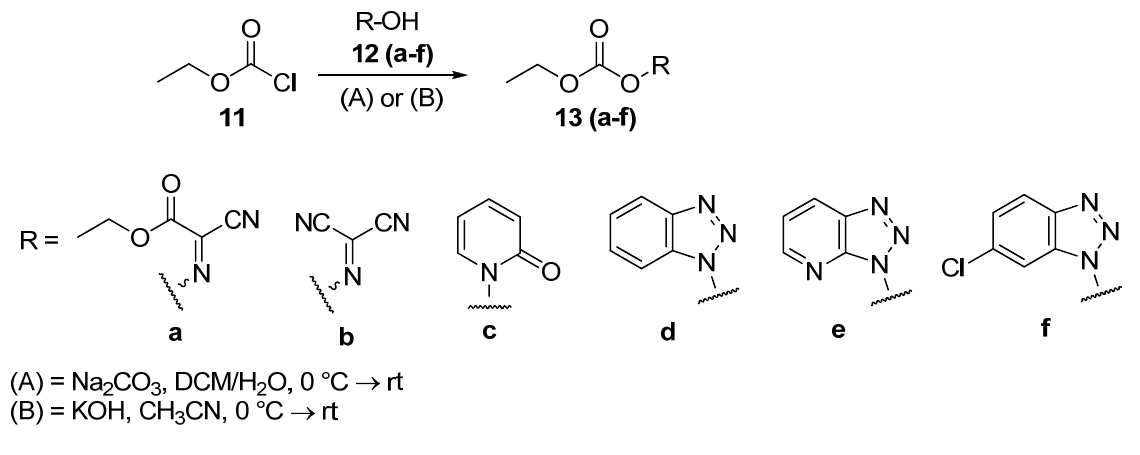
Table 1. Yield, m.p. and elemental analysis of the carbonate derivatives 13 .